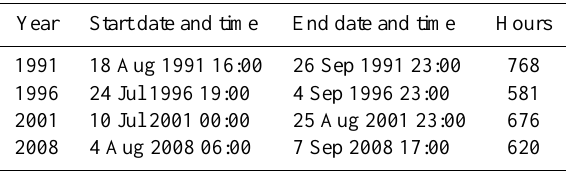
Table 1. Start and end date and time (UTC) of the hourly Oden aerosol data utilized in the present paper in 1991, 1996, 2001, and 2008, and the number of hourly averages after screening for possi- ble pollution from the